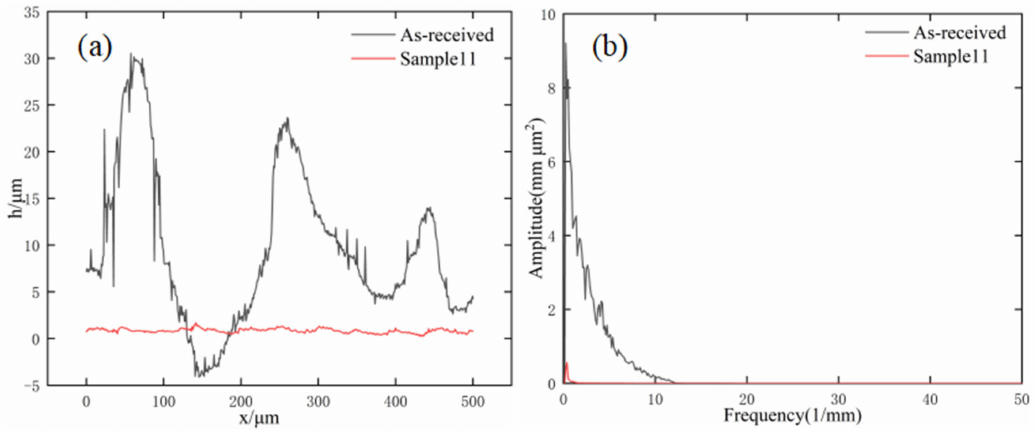
Figure 6. Analysis of surface topography and power spectral density before and after polishing: ( a ) surface topography; ( b ) power spectral density